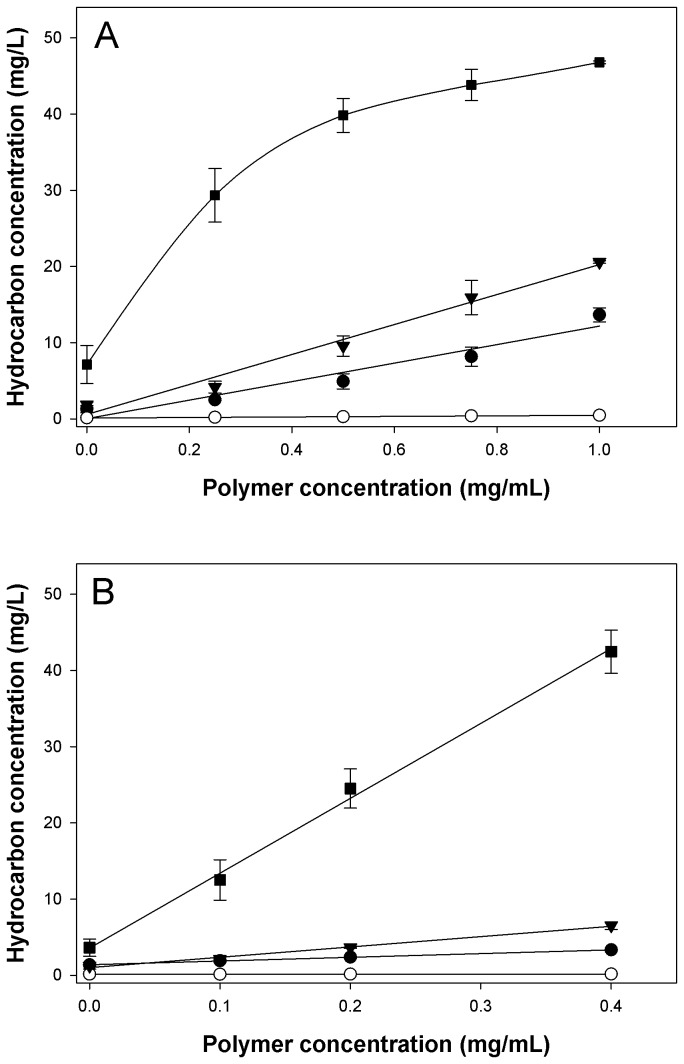
Effect of

Halomonas
 strain TG39 exopolysaccharides (EPS) on the dissolution of aromatic hydrocarbons.Relationship of EPS concentration to aromatic hydrocarbon solubilization in diluted filtered seawater (0.1 M; pH 8.0) (A) and in undiluted filtered seawater (0.6 M; pH 8.0) (B). Note difference in scale of x-axis (polymer conc.) between plots. The EPS used was from
Halomonas
 sp. strain TG39. Phenanthrene (solid circles); pyrene (open circles); fluorene (inverted triangles); biphenyl (squares).